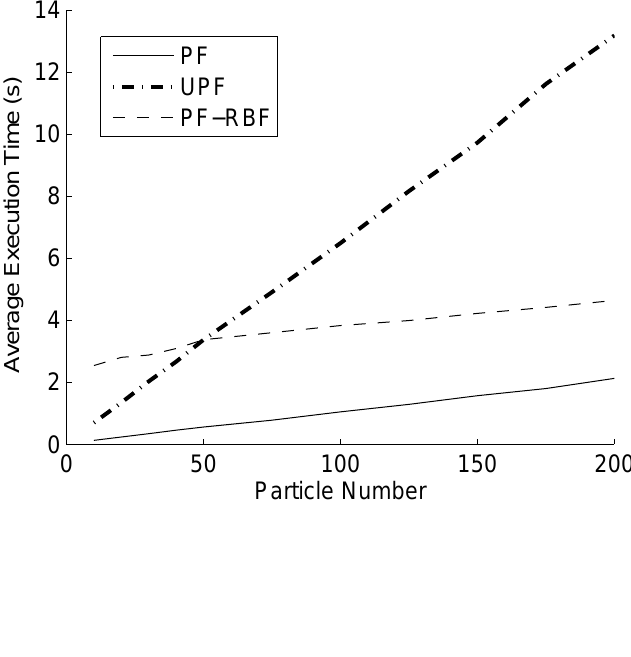
Figure 5. The average execution time of three particle filters for 60 steps tracking over 100 independent